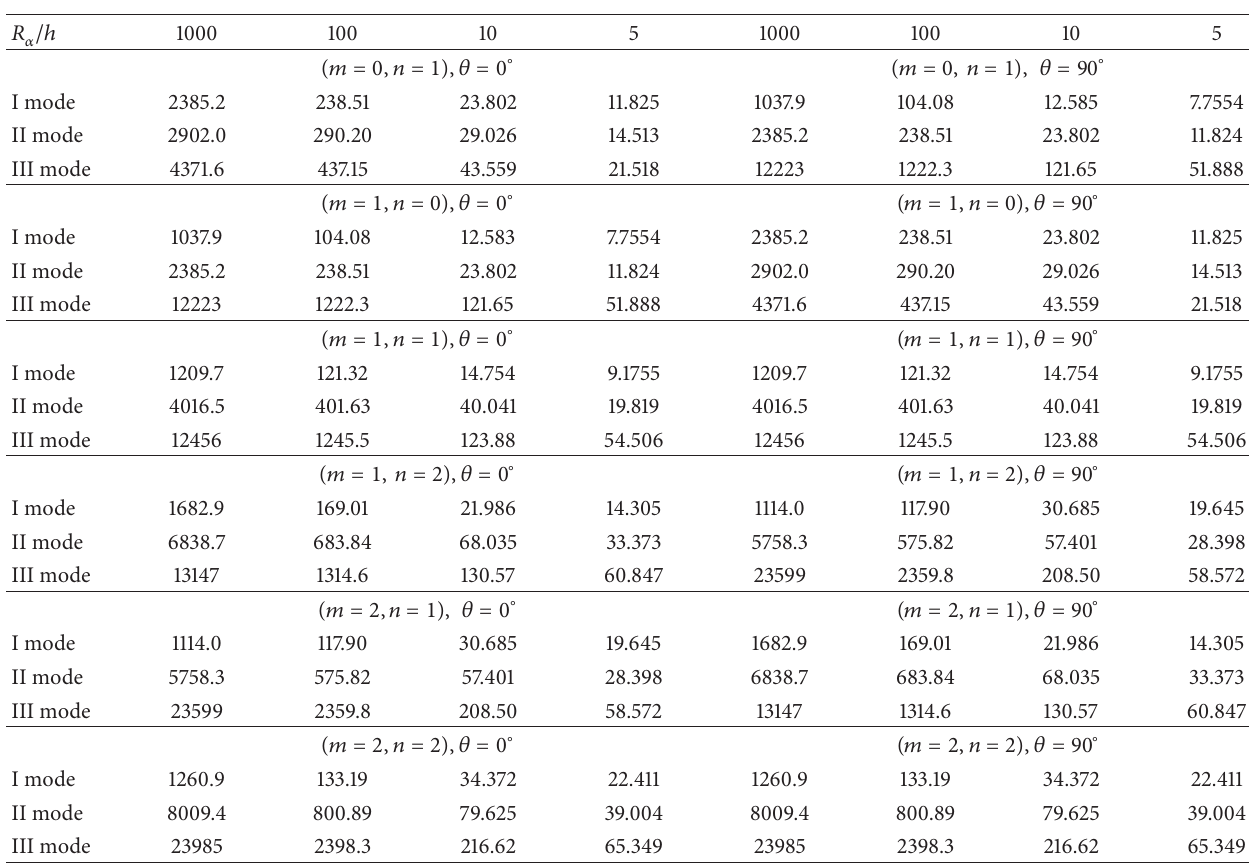
Table 14: Benchmark 10. Simply supported orthotropic spherical shell panel. First three vibration modes in terms of no-dimensional circular frequency 𝜔 = 𝜔(𝑎 2 /ℎ)√𝜌/𝐸 2 forseveralcombinationsofhalf-wavenumbers 𝑚 and 𝑛 . 𝑀 = 100 fictitiouslayersand 𝑁 = 3 orderofexpansion for the exponential